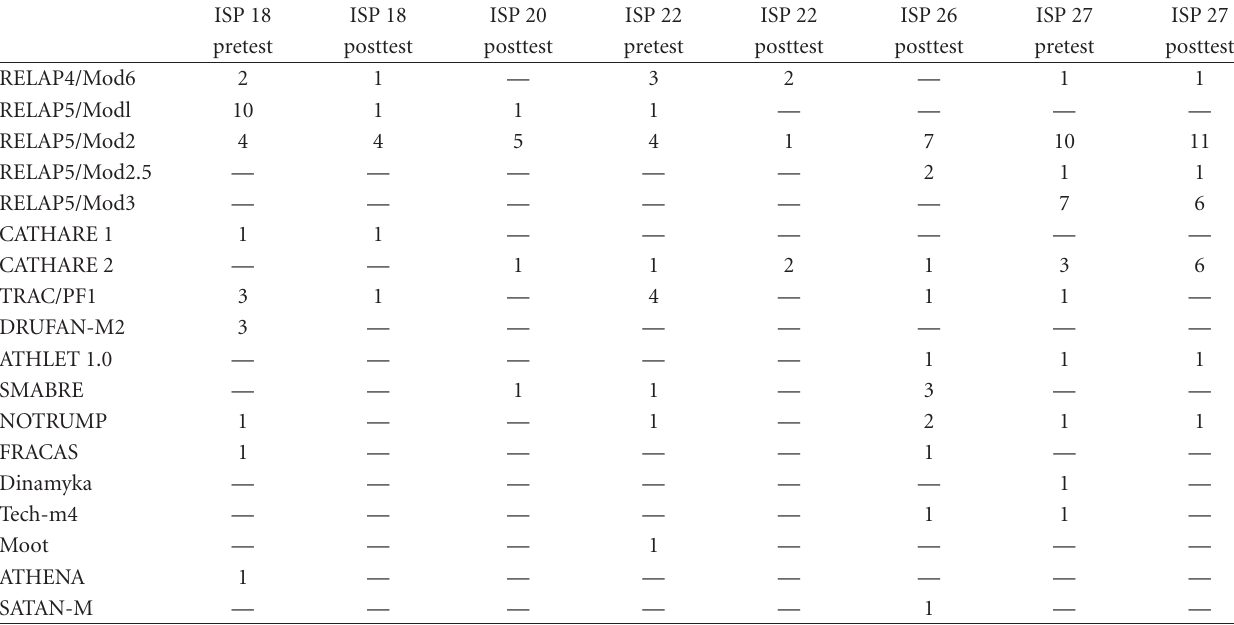
Table 6: Participants per code per